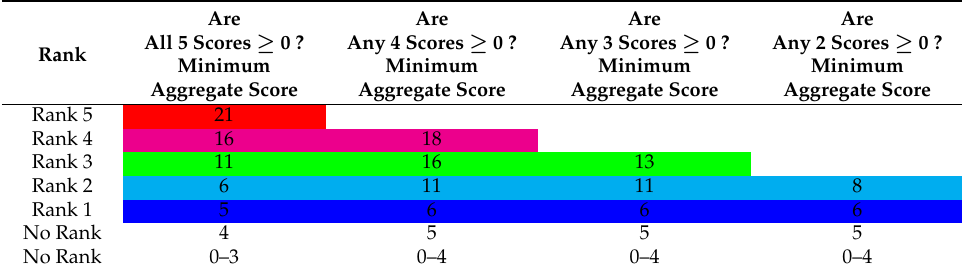
Table 3. Mature prediction ranks table.